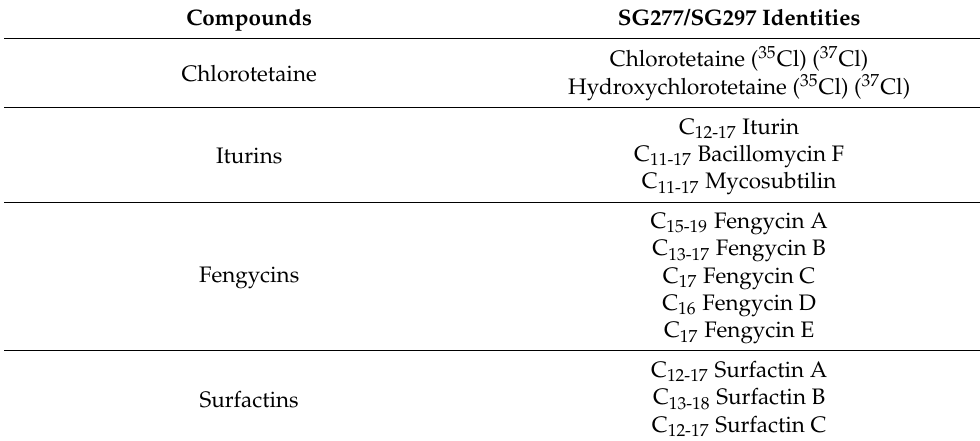
Table 1. Components identified during MALDI-TOF analysis for peaks collected during RP-HPLC separation of the SG277 active SEC